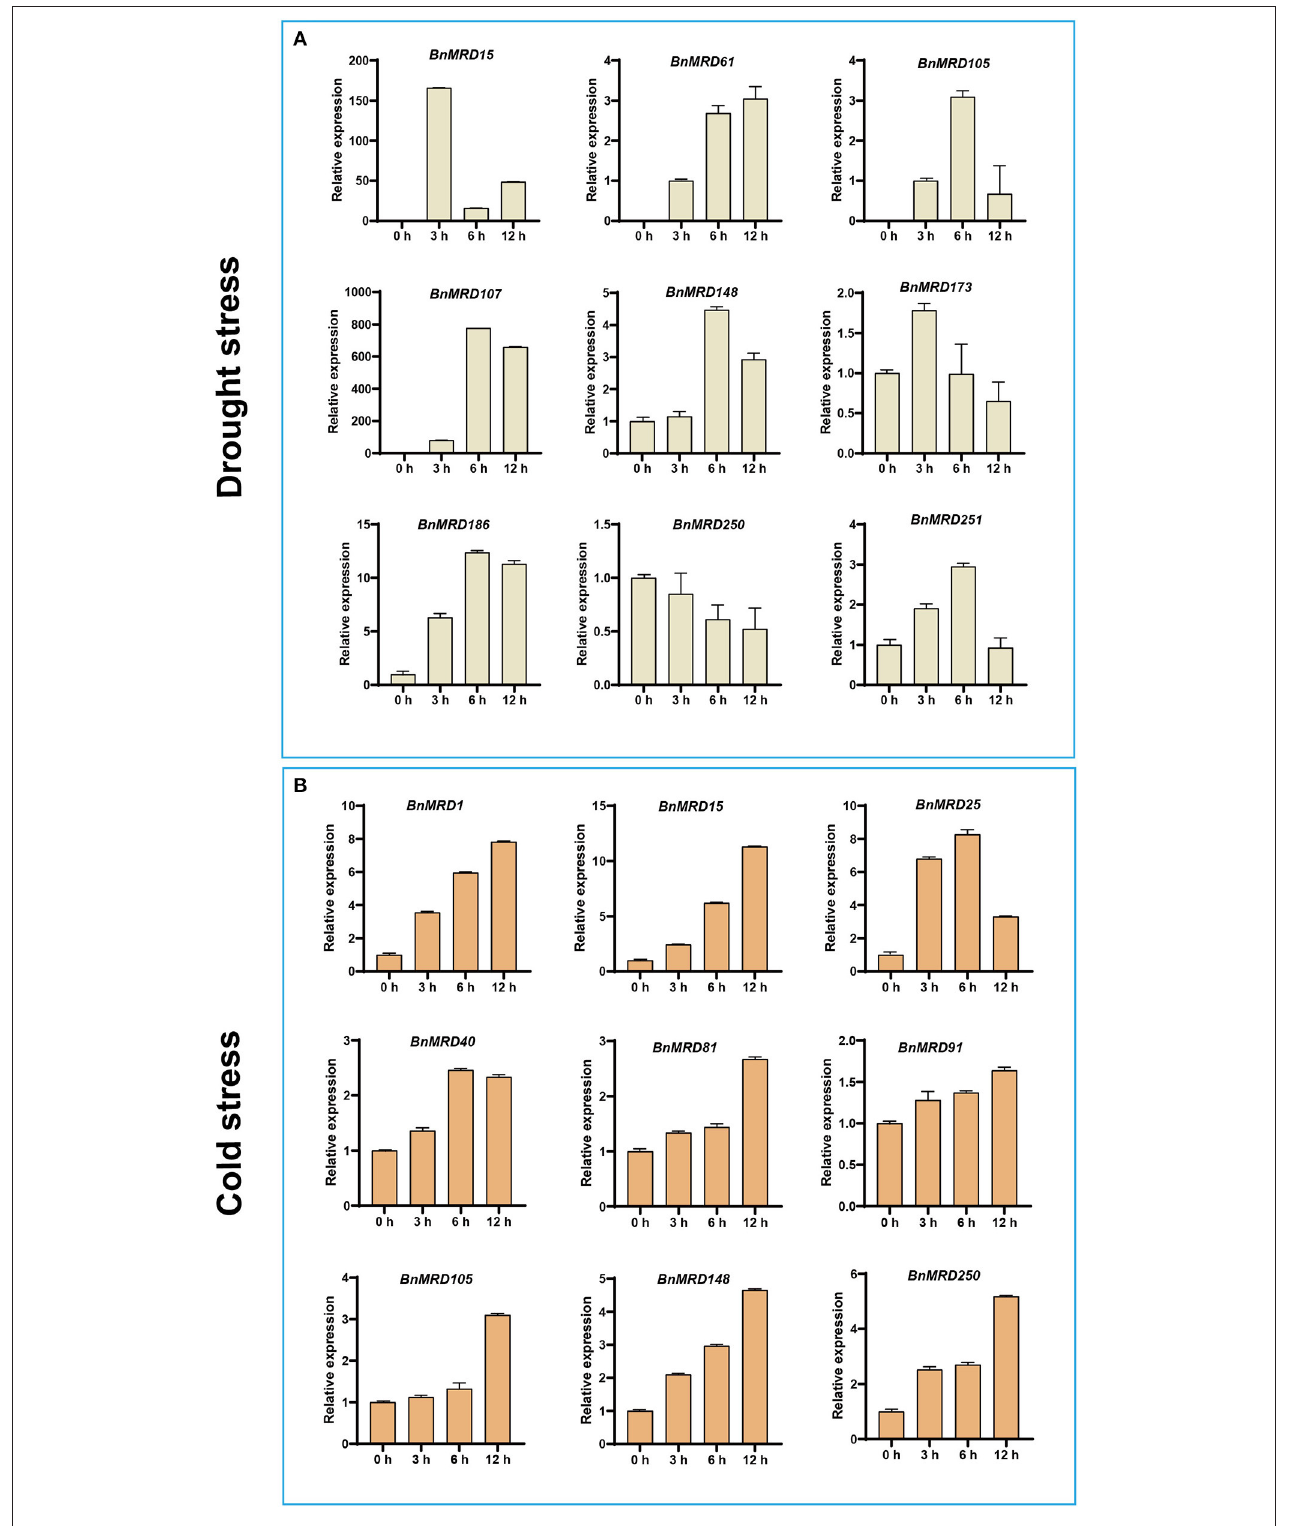
FIGURE 8 | Expression analysis of 13 BnMYB-related genes under (A) drought treatment and (B) cold treatment by qPCR. The expression levels were normalized to BnActin . Data represented the mean ± SE ( n = 3).